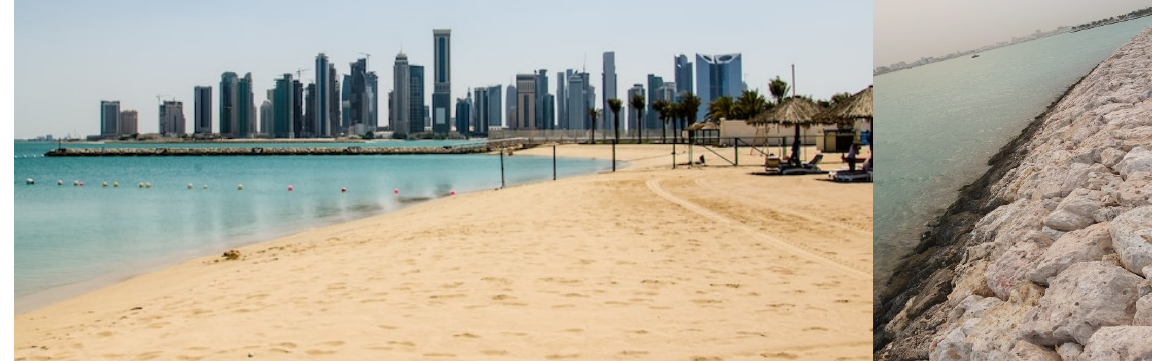
Figure 15. Shorelines of Segment C.